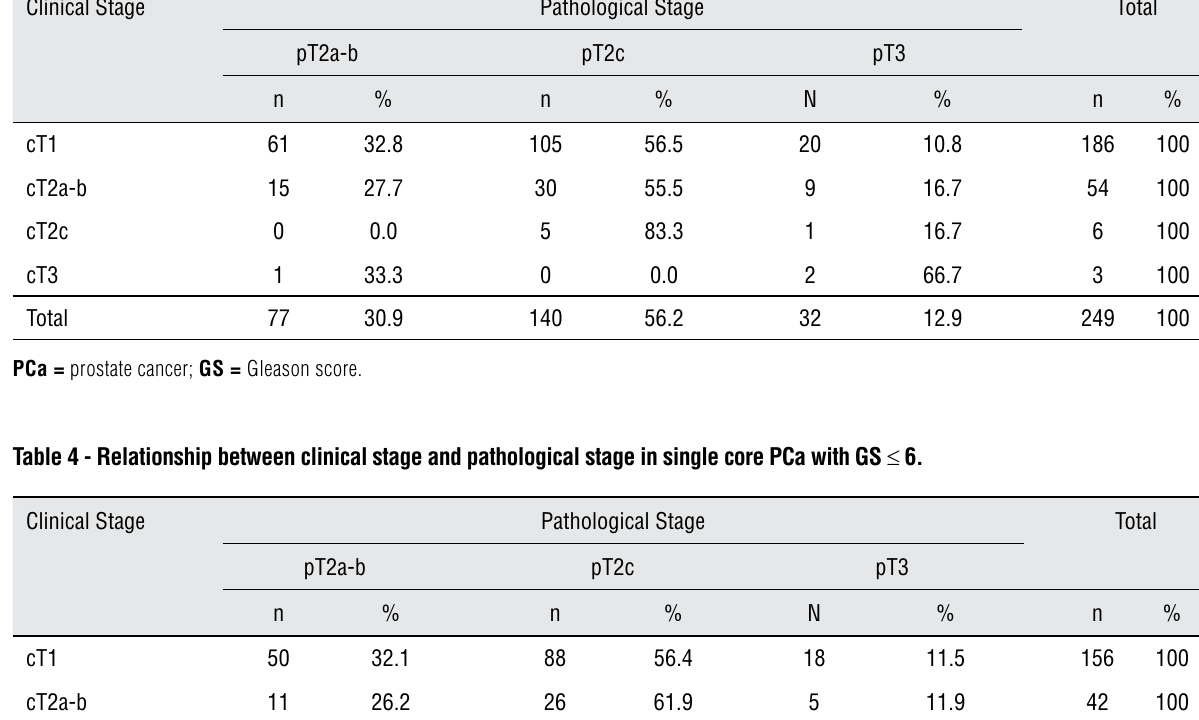
Table 3 - Relationship between clinical stage and pathological stage in single core PCa. Clinical Stage